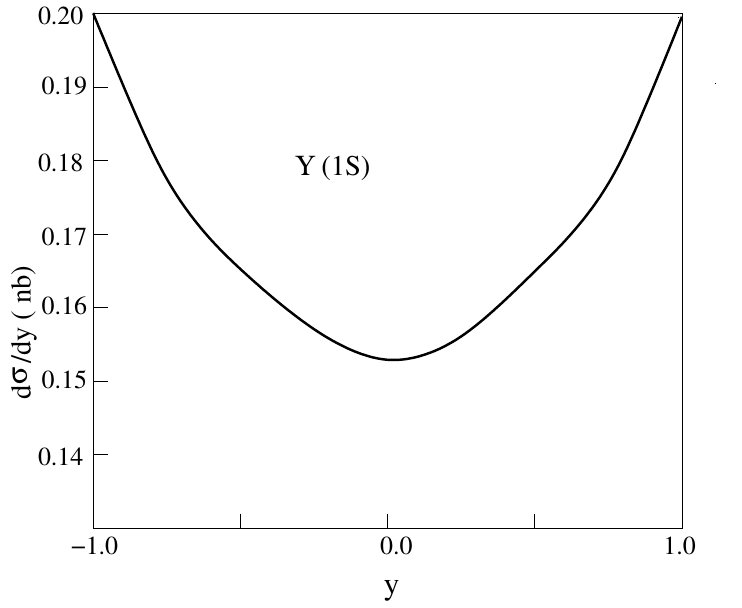
p s pp =5.02 TeV Pb-Pb collisions producing (cid:7)(1 S ) with (cid:21) = 0.